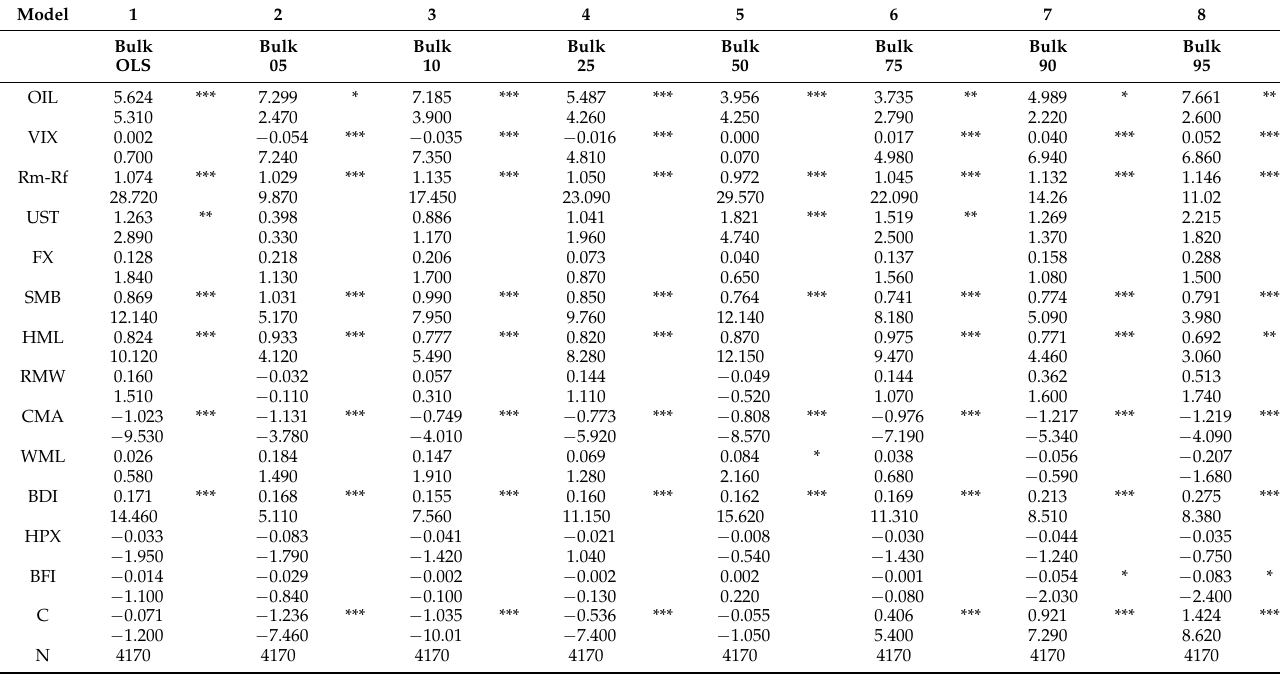
Table 3. Ordinary least square (OLS) and quantile regression estimates for the dry bulk